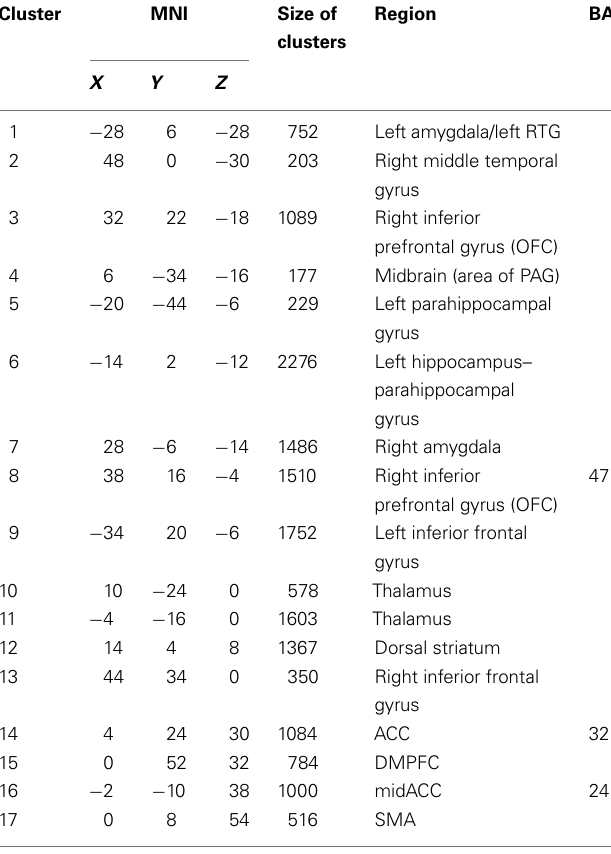
Figure 2 for an illustrative summary and Evidence for a